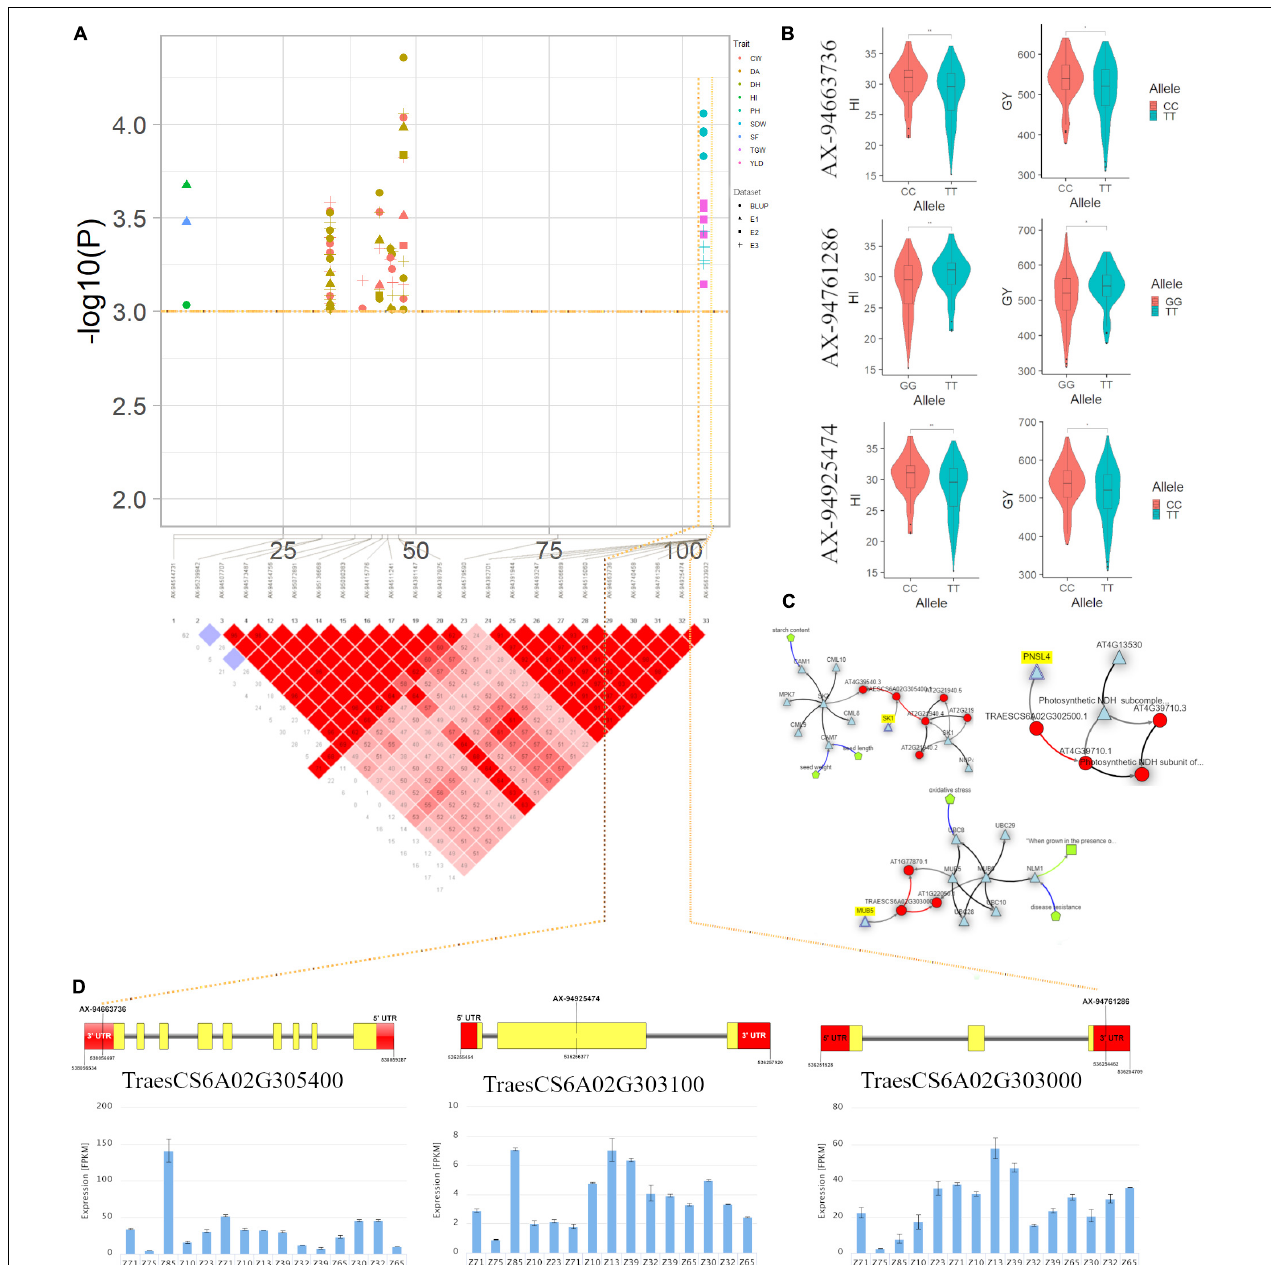
FIGURE 6 | (A) Local Manhattan plot and linkage disequilibrium (LD) heatmap of stable SNPs associated with grain yield (GY) and harvest index (HI) on chromosome 6A. (B) Effect of different alleles of associated SNP markers on the phenotypic values of GY and HI. (C) Network generated for three candidate genes. (D) Structure of three candidate genes and their in silico tissue and growth specific expression